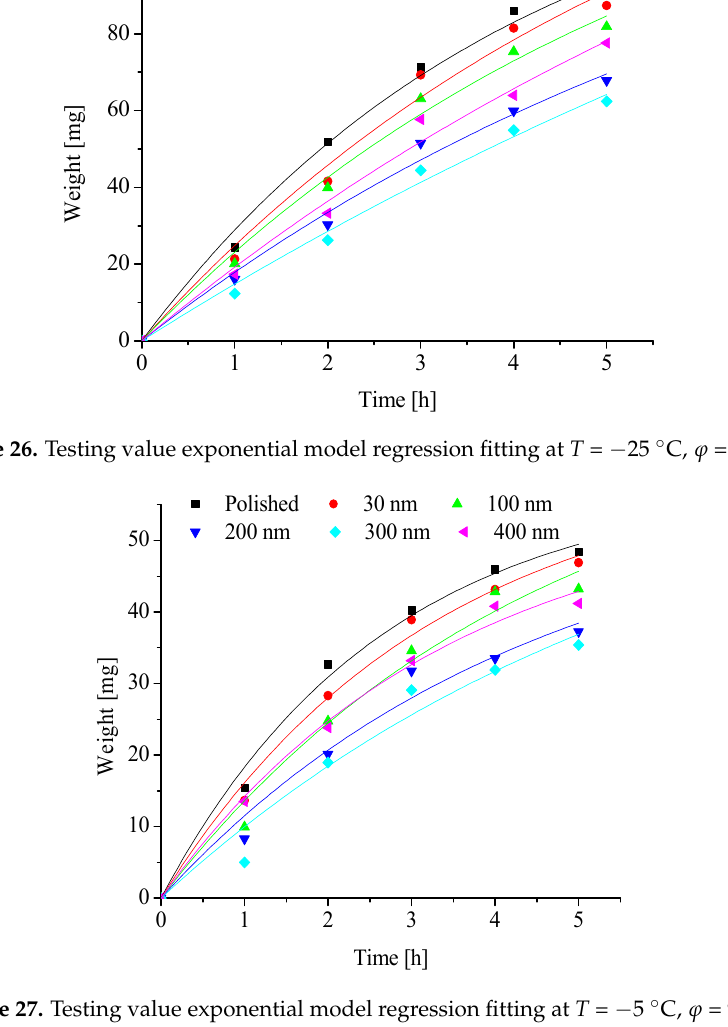
Figure 27. Testing value exponential model regression fitting at T = − 5 °C, φ = 90%.